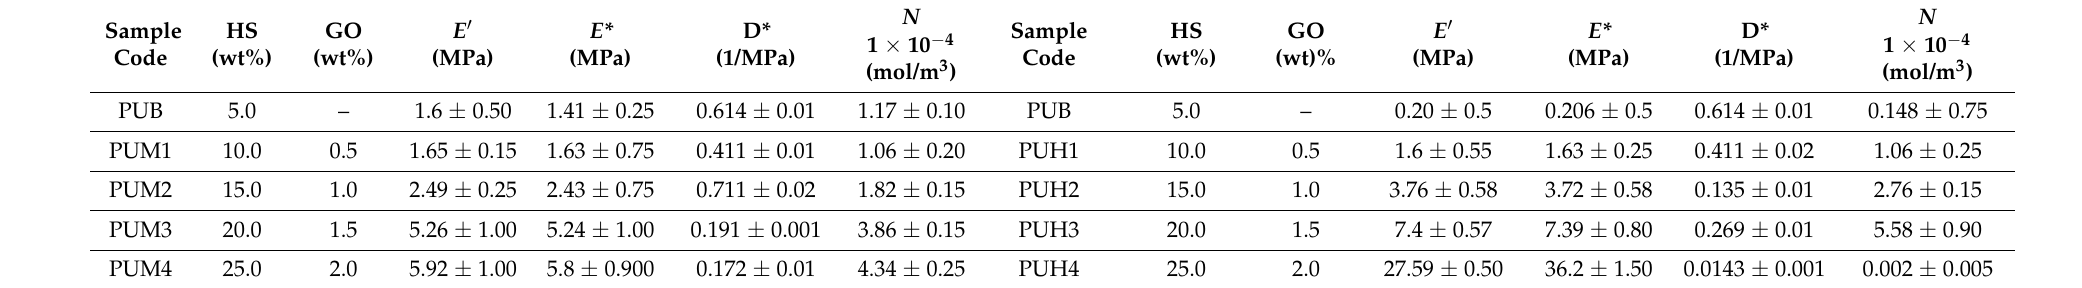
Table 4. Mechanical profile of the PU composites induced with